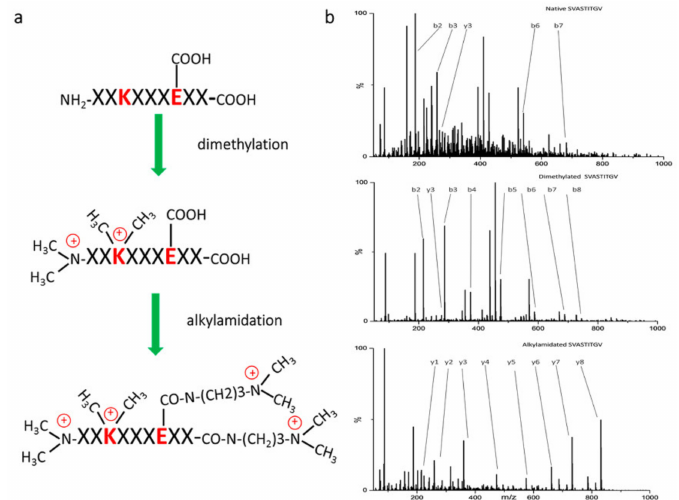
Figure 2. Derivatization reaction to increase sequence coverage and ionization e ffi ciency of peptides. (A) Scheme of the derivatization and ( B ) tandem MS spectra of synthetic peptide (SVATITGV) in native, dimethylated, and alkylamidated form. Reprinted with permission from Chen et al. [39], copyright year 2018, American Chemical